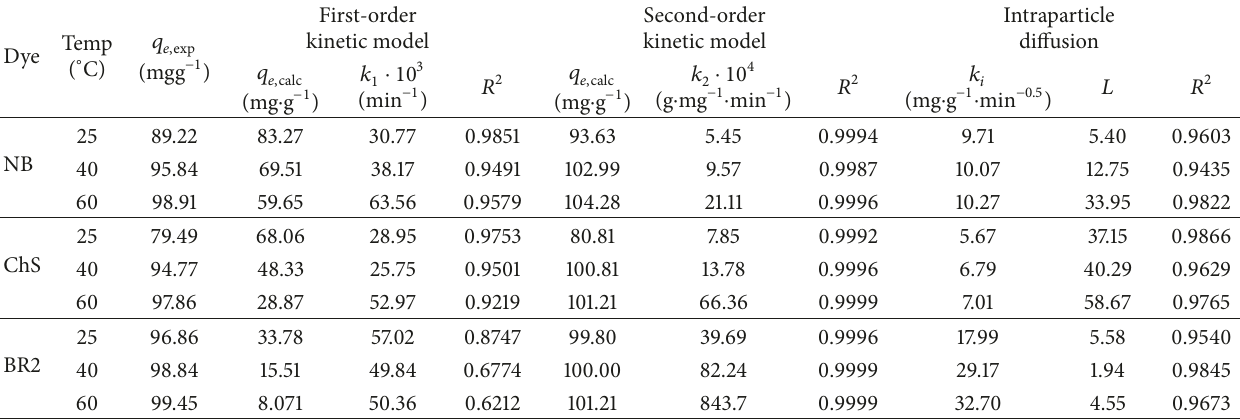
Table 4: Comparison of experimental and calculated 𝑞 𝑒 values and rate constants for adsorption of NB, ChS, and BR2 dyes on PM-4